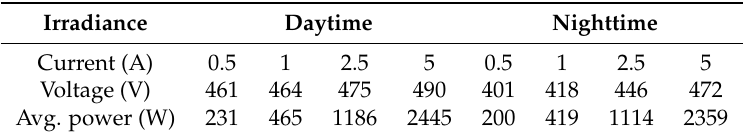
Figure 8. Controller response to a pulse of 200 ms under different irradiance conditions—DIV (1 W/m 2 ) and LIV (800 W/m 2 )—and for several current references scenarios. Table 1. Behaviour of PV panels under different conditions during direct polarisation: Daytime (800 W/m 2 ) and Night-time (1 W/m 2